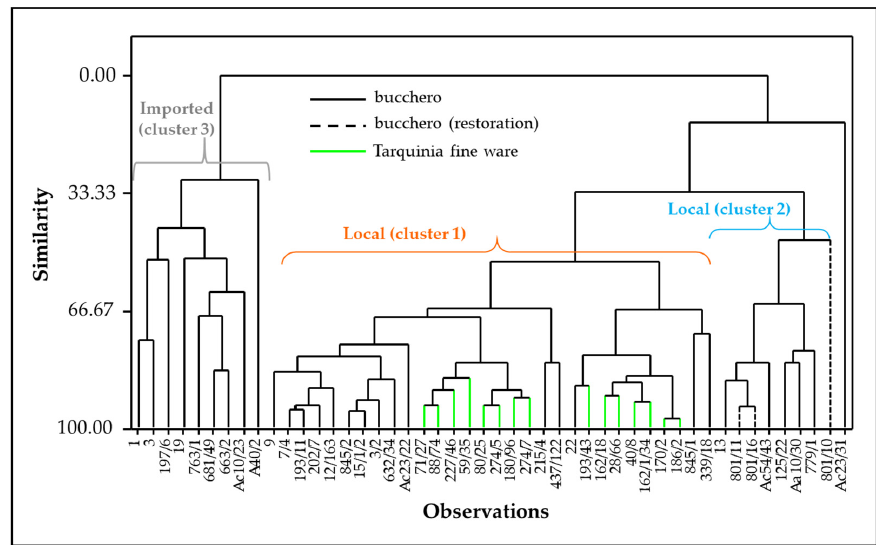
Figure 4. Dendrogram obtained from the cluster analysis of the elemental composition of bucchero pottery (black lines) from the excavation of La Civita di Tarquinia, compared with the locally produced fine pottery (green lines). The black dashed lines indicate the bucchero samples considered in view of a virtual reconstruction (see text, Section 3.3).